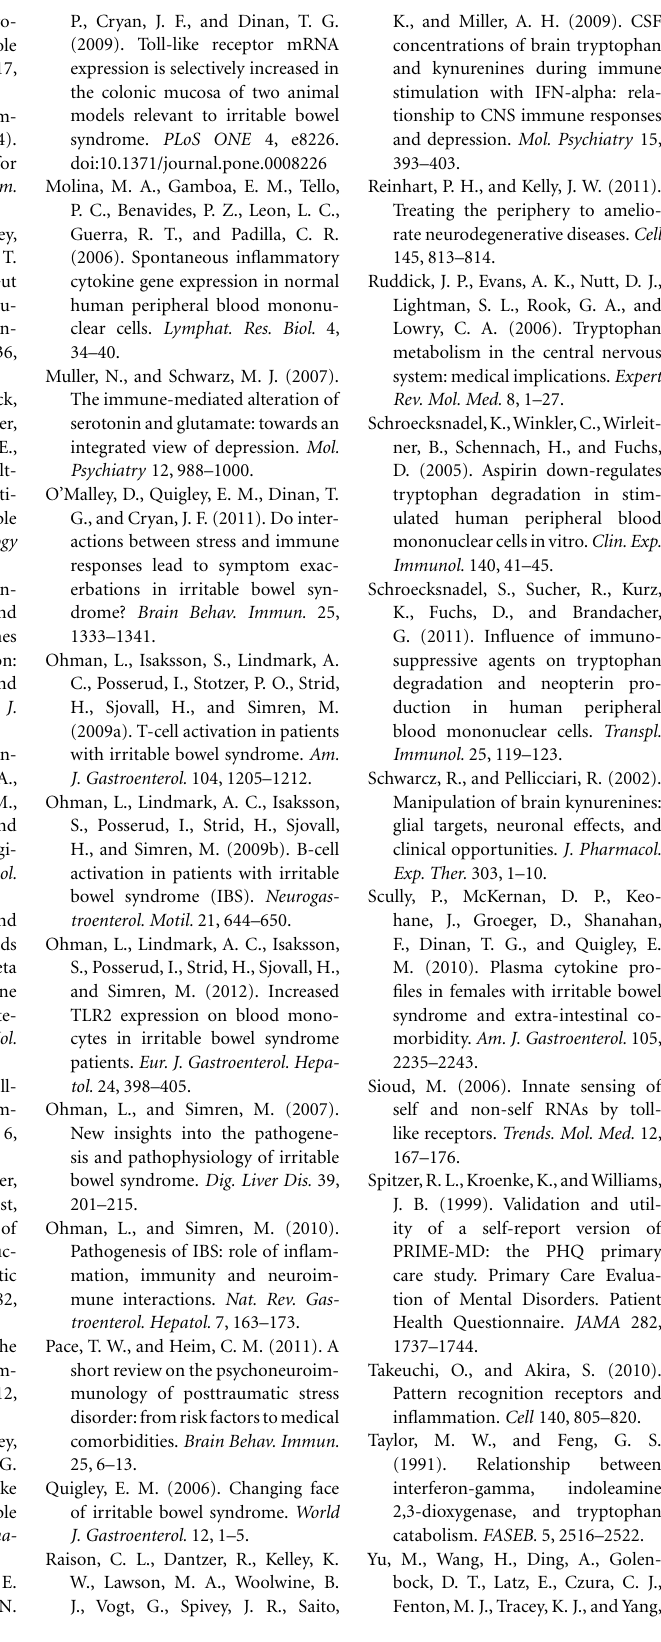
table bowel syndrome: relation- ship to interferon-gamma, sever- ity of symptoms and psychi- atric co-morbidity.